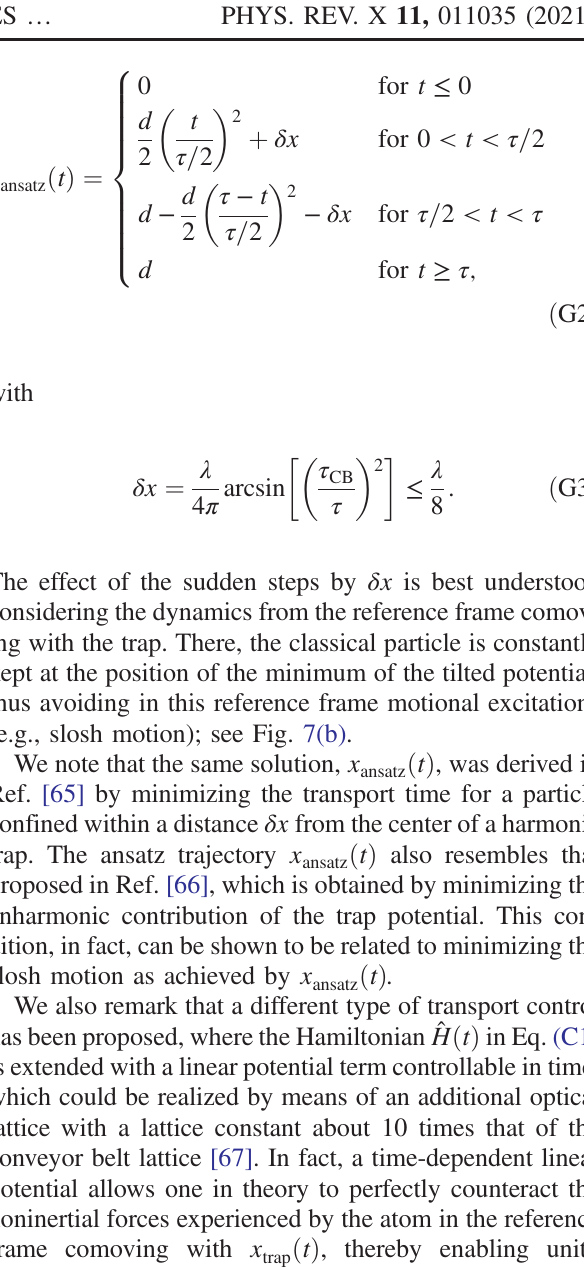
ffiffiffiffiffiffiffiffiffiffiffi p 2 n= π ; ð G1 Þ